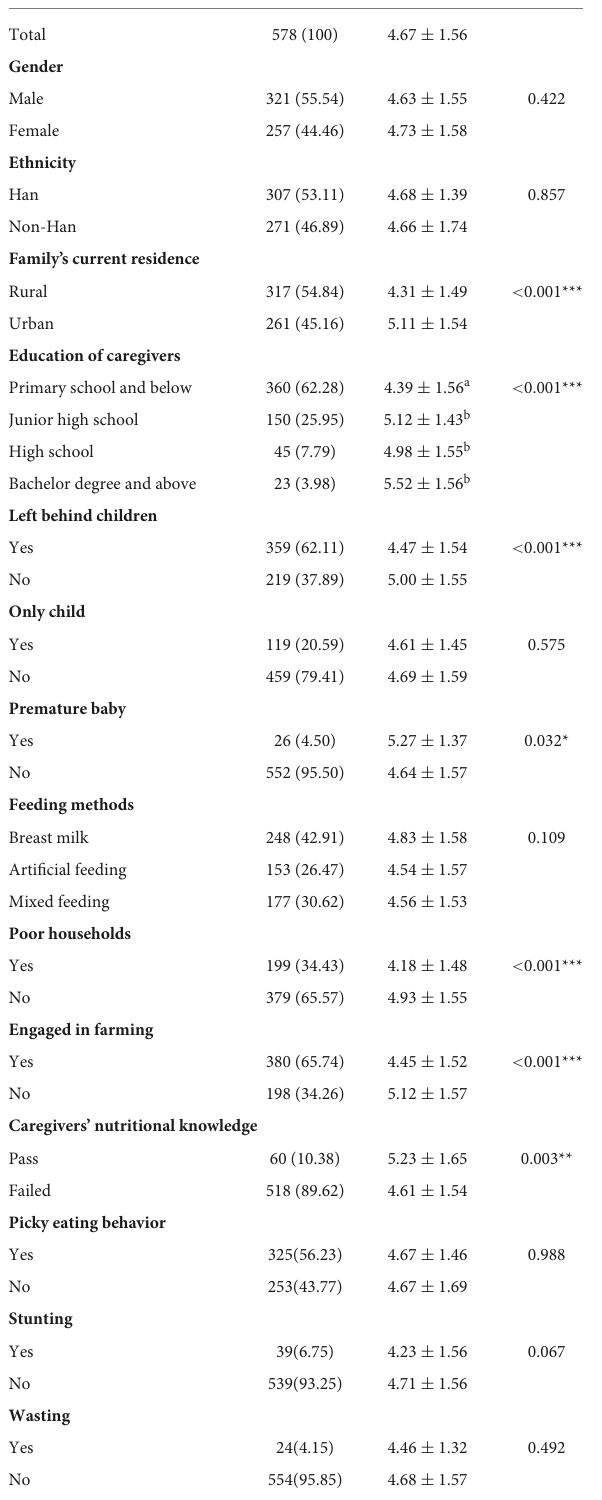
Consumption of each food group The most frequently consumed food groups were starchy staples (99.65%), followed by dark green leafy vegetables (75.78%), other fruits and vegetables (68.17%), meat and fish (54.50%), and eggs (54.33%). In comparison, the groups of other vitamin A-rich fruits and vegetables (44.98%); milk and milk products (39.10%); legumes, nuts, and seeds (30.97%)